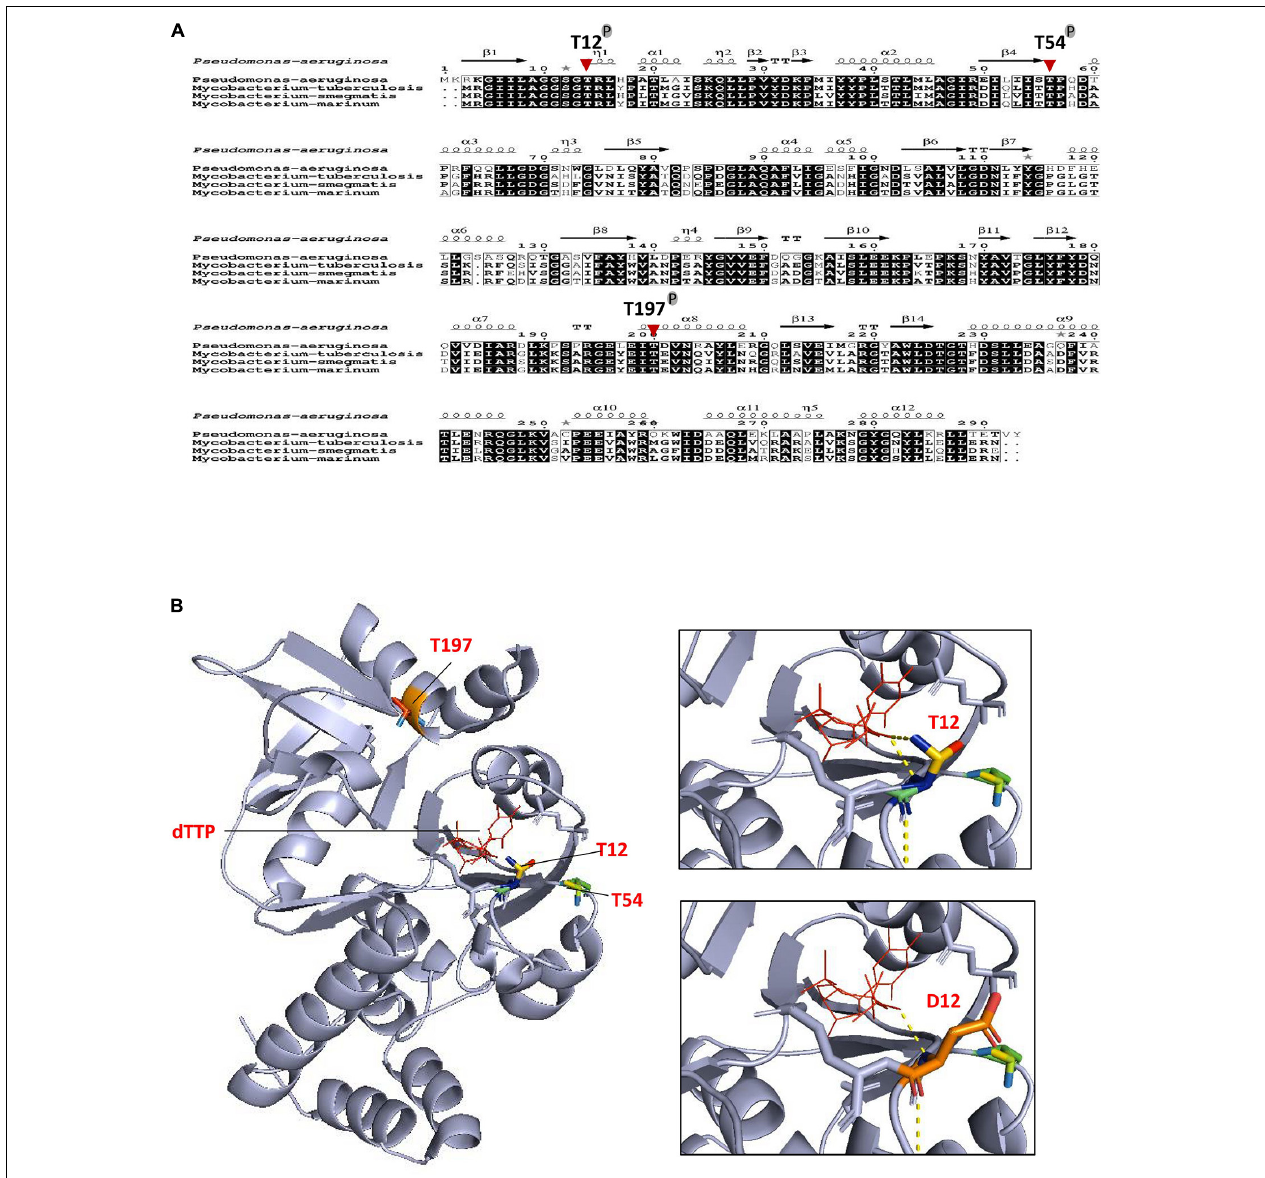
FIGURE 3 | Conservation of phosphoacceptors in RmlA orthologs. (A) Multiple sequence alignment of RmlA sequences from Pseudomonas aeruginosa to mycobacterial species. The alignment was performed using ClustalW and Espript. Residues conserved in all species are shown in black boxes. The three phosphorylation sites of RmlA are indicated. Protein secondary element assignments are represented above the sequences. Numbering of amino acids corresponds to the RmlA protein from P. aeruginosa . (B) Localization of T12, T54, T197 phospho-sites in the three-dimensional structure of RmlA. Overall view (left panel) showing the RmlA monomer structure in ribbon representation with the α -helix and the β -sheet. Close-up view (right panel) indicates side chains of residues delineating the active site hydrophobic